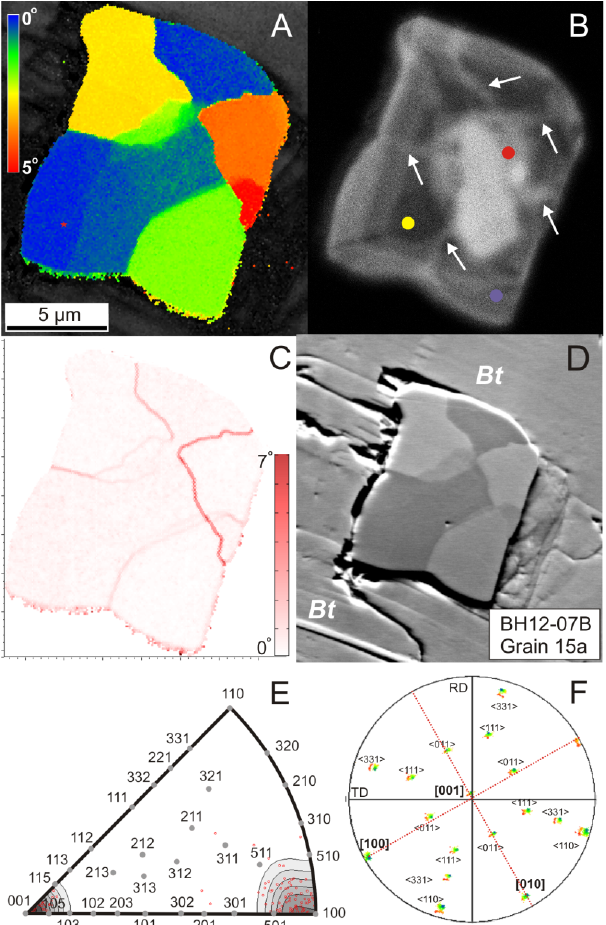
Figure 5. Grain BH12-07B_15a, lattice distortion type (III) case 2. (a) EBSD map color-coded for zircon misorientation with respect to a reference point (red star marker). (b) CL image; bright traces (marked by white arrows) correspond to subgrain boundaries; col- ored dots represent the relative degree of crystallinity; color coding as in Fig. 2b. (c) EBSD map of zircon showing the misorientation between neighboring data points. (d) Orientation contrast image (FSE); Bt: biotite. (e) Inverse pole figure plot of the distribution den- sity of misorientation axes shows concentrations around < 001 > and < 100 > . (f) Pole figure plot showing zircon crystal directions (lower-hemisphere equal area projection) colored as in (a) . Labels indicate the crystallographic directions. Dashed red lines show the subgrain boundary orientations.